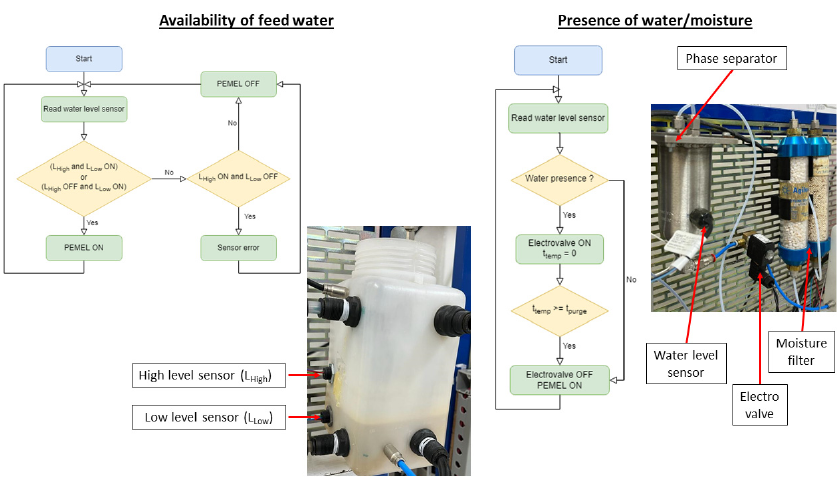
Figure 4. Control algorithms for feed water and presence of moisture. Equipment involved.